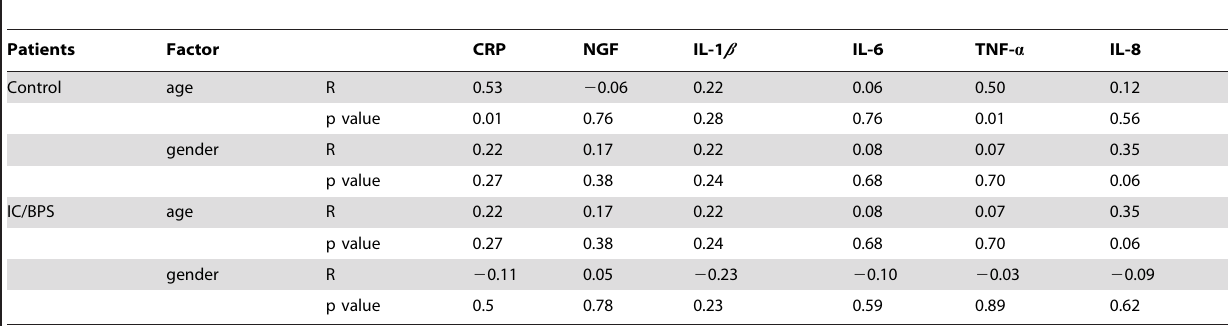
Table 2. The correlation coefficient between serum CRP, NGF and cytokines/chemokines and age or gender in IC/BPS and control